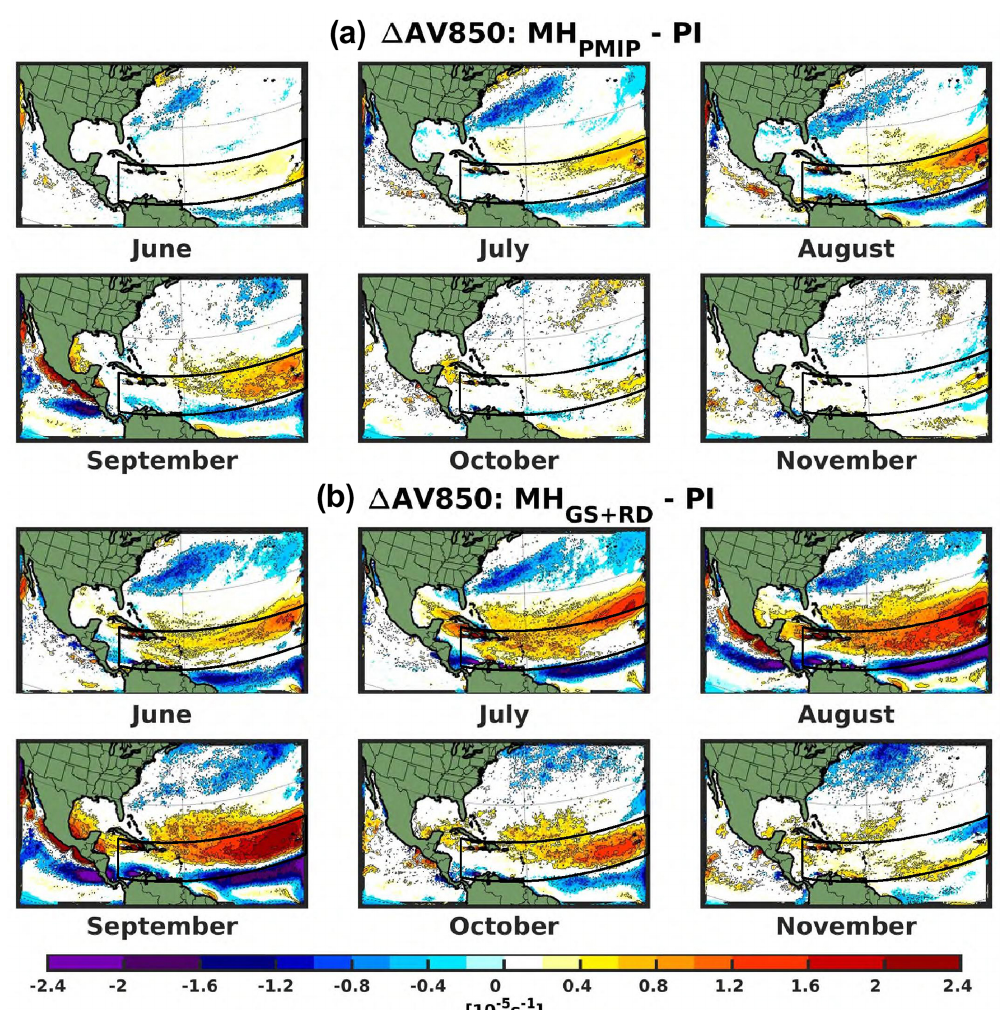
Figure A13. Monthly mean changes in 850hPa absolute vorticity for the (a) MH PMIP and (b) MH GS + RD experiments relative to PI. The black box shows the approximate present-day MDR. Only values that are significantly different at the 5% level using a local (grid-point) t test are shaded. The contour lines follow the color-bar scale (dashed, negative anomalies; solid, positive anomalies); the 0 line is omitted for